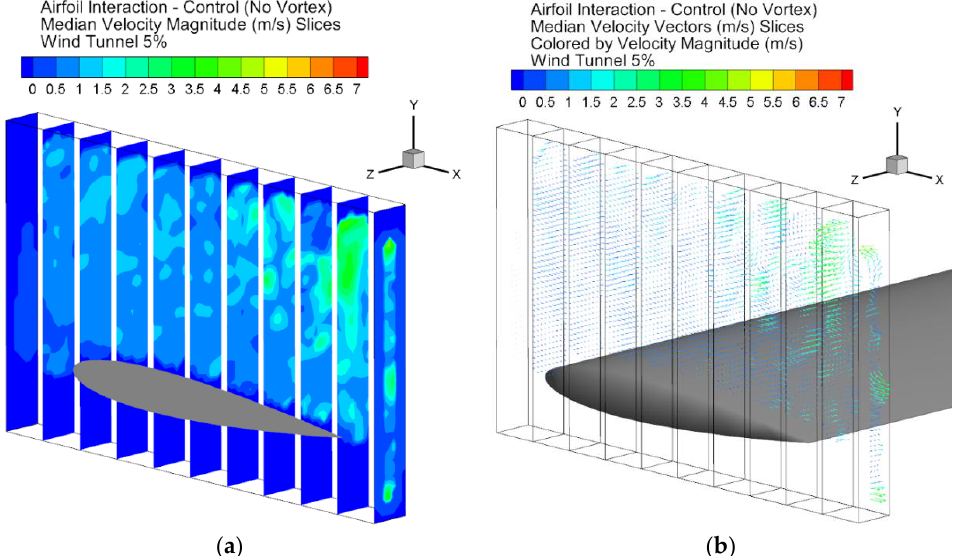
Figure 23. Airfoil interaction control (without the vortex tube) instantaneous median frame: ( a ) velocity maps and ( b ) velocity vector. With the inclusion of the vortex tube, the presence of the vortex near the surface of the airfoil is immediately noticeable. As discussed in the review of the numerical simulations of Garmann and Visbal [5], the splitting of the vortex over the two airfoil surfaces can be observed in Figure 24.